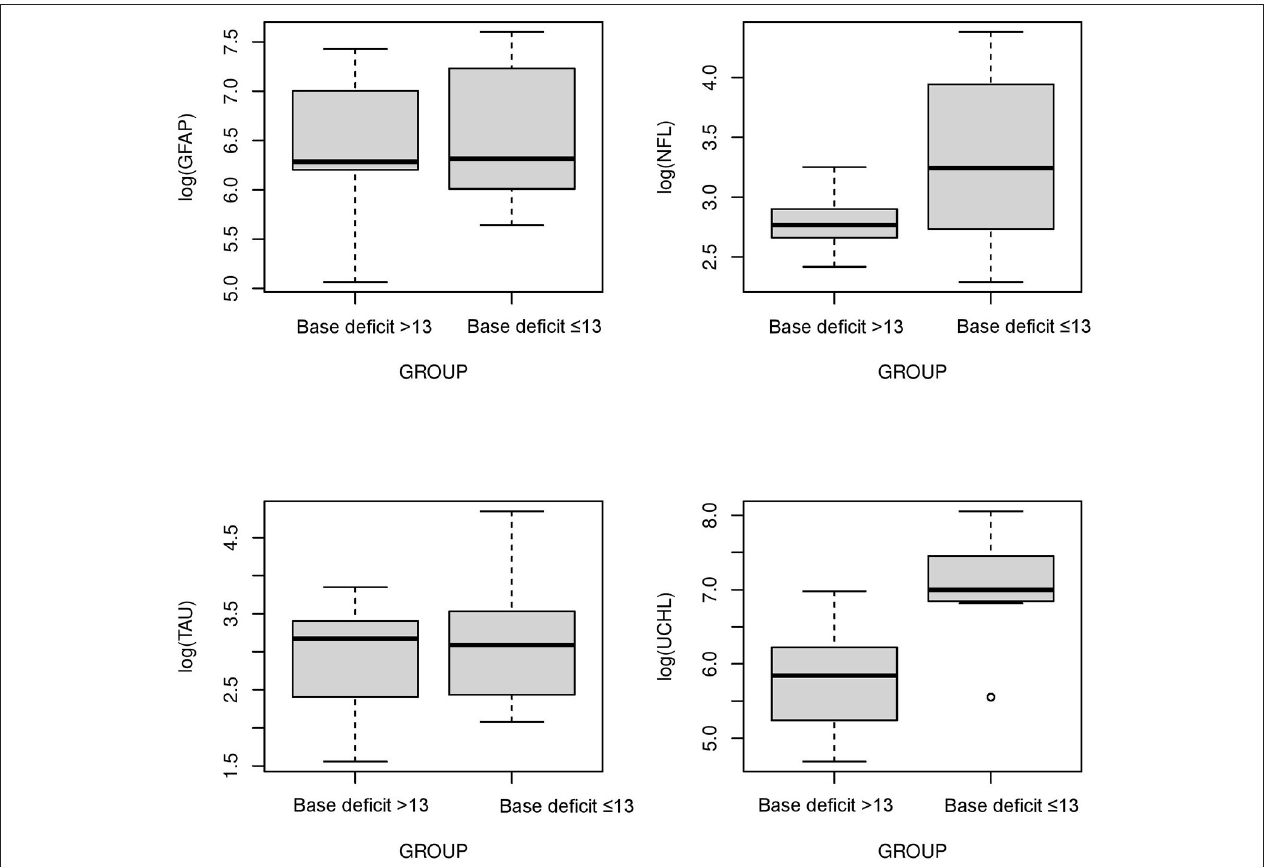
FIGURE 4 | Serum concentrations of GFAP, NFL, Tau, and UCH-L1 in neonates with a base deficit of 13 or greater compared to neonate with base deficit < 13. UCH-L1 low concentration was higher in neonates with a base deficit of 13 or greater ( P < 0.05) (Mean ± STD). Serum concentration of GFAP, NFL and Tau were similar between neonates with base deficit of 13 or greater and base deficit <